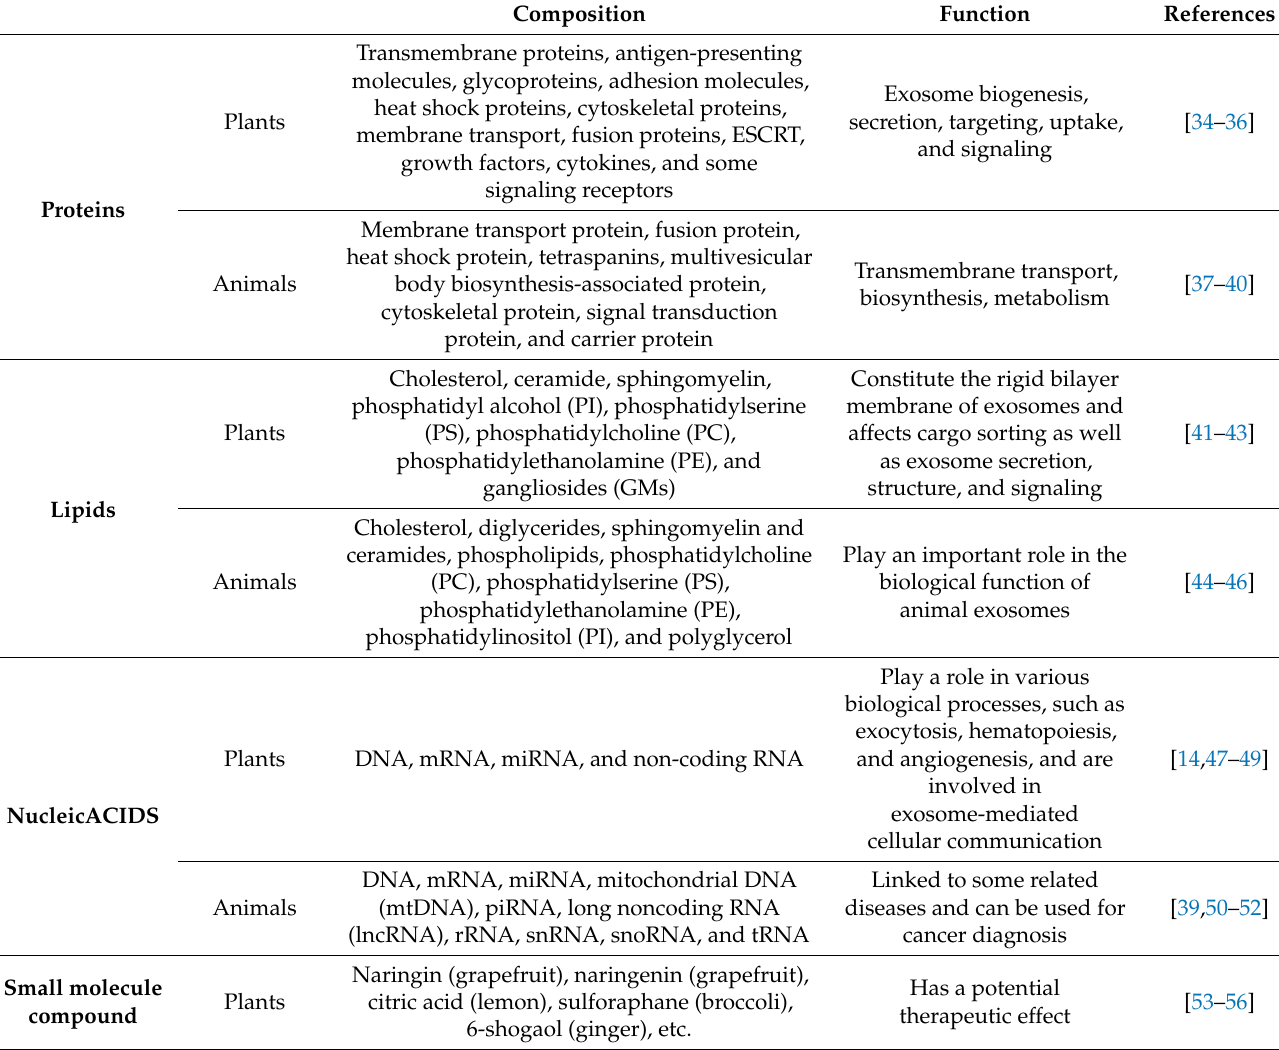
Table 2. Composition of exosomes in plants and